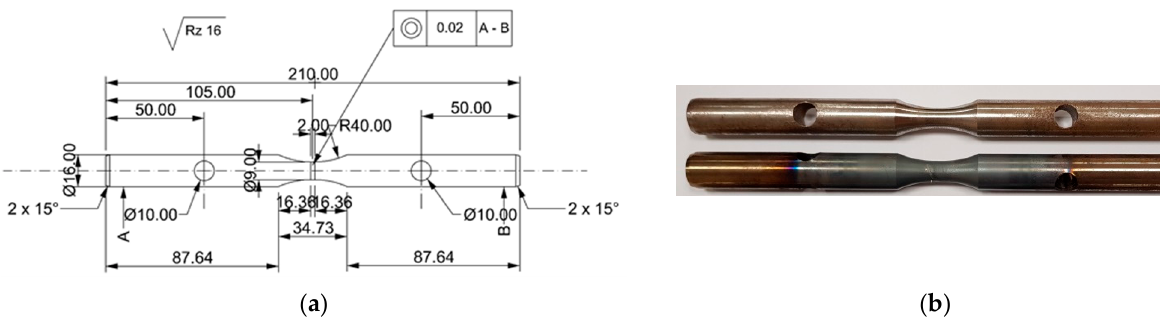
Figure 2. Samples for physical modelling tests: ( a ) technical specification and ( b ) general view of 20MnB4 steel samples before and after physical modelling.